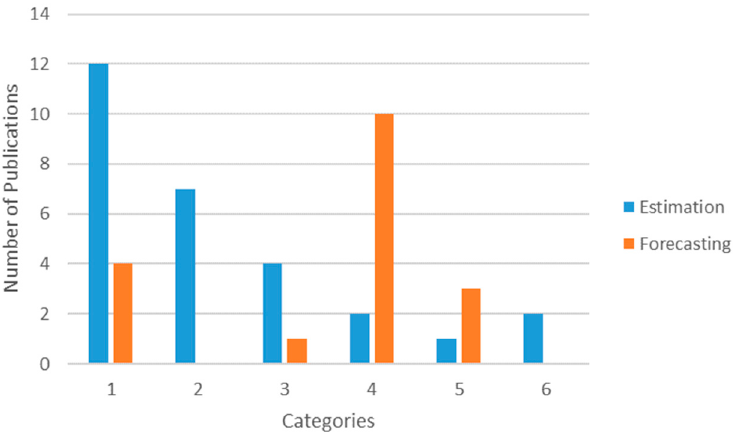
Figure 6. Number of types of studies (estimation vs. forecasting) per group. Category 1: Identifying relevant predictors and understanding the non-linear relationship with air pollution. Category 2: Image-based monitoring and tackling low spatial resolution from non-specific/low resolution sensors. Category 3: Considering land use and spatial heterogeneity/dependence. Category 4: Hybrid models